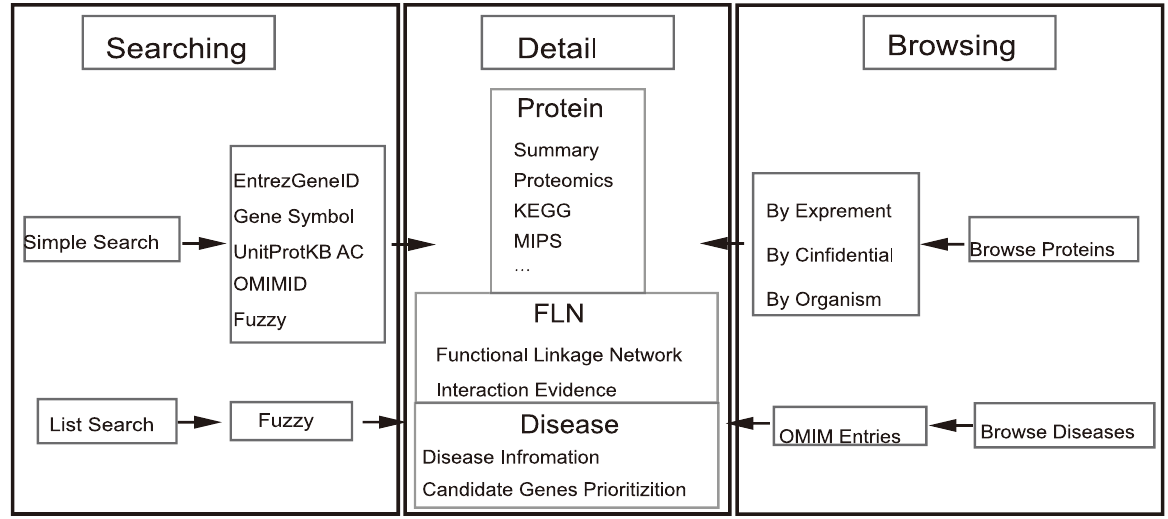
Figure 7. System architecture and main contents of MitProNet. MitProNet is composed of three sections including mitochondrial protein part lists, annotations of mitochondrial protein and disease